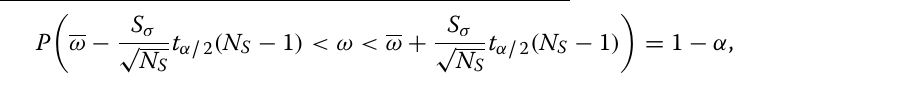
α )% confidence interval − 2 S σ 1 ) t α / 2 ( N S wide from √ N S − α )%. −